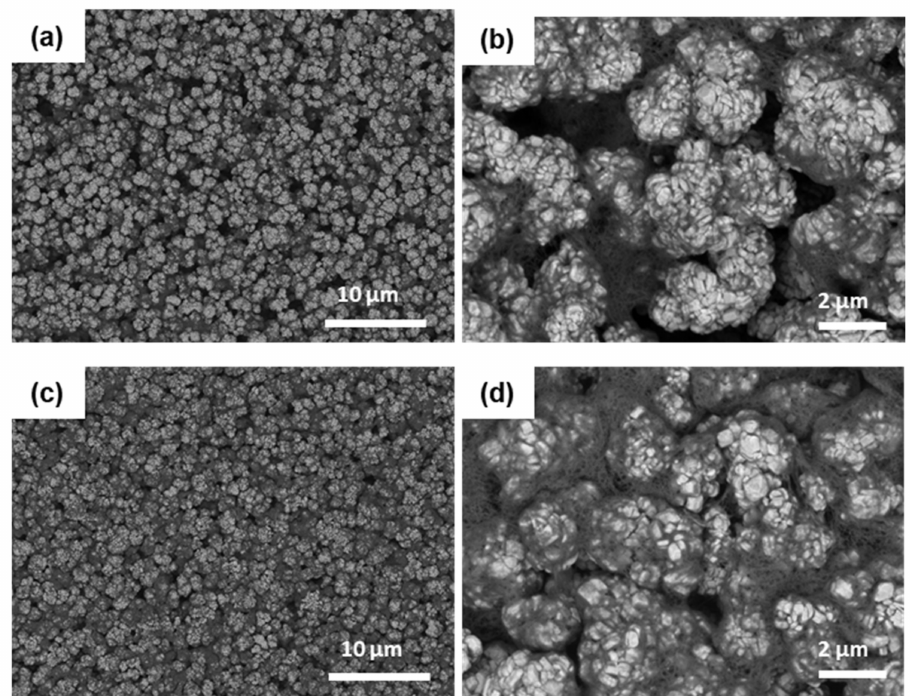
Figure 2. Scanning electron microscope (SEM) images of fabricated electrodes by mixing the cathode material with Sample A and C dispersions. ( a , c ) Low magnification SEM images of fabricated elec- trodes by Sample A and C, respectively. ( b , d ) High magnification SEM images of ( a , c ),